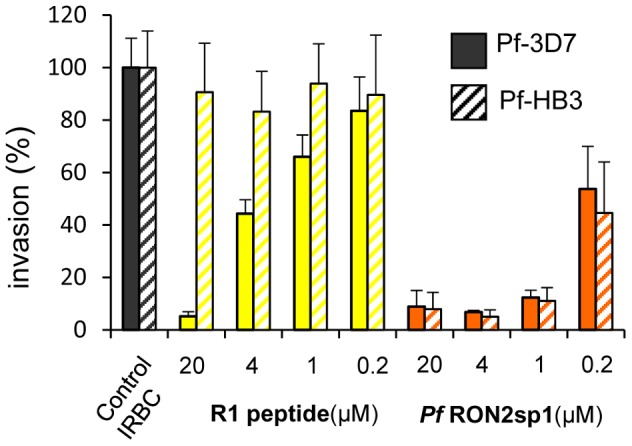
Highly potent cross-strain inhibition of red blood cell invasion of PfRON2sp1.Comparison of PfRON2sp1 and R1 peptides (concentrations 0.2 to 20 µM) in inhibiting red blood cell invasion by P. falciparum 3D7 or HB3 highlights the higher inhibitory efficiency and cross-strain reactivity of PfRON2sp1. Parasitemia of control infected red blood cells (IRBC) 16 hours post-invasion was used as the 100% invasion reference. Means (± SD for N = 3) are shown.